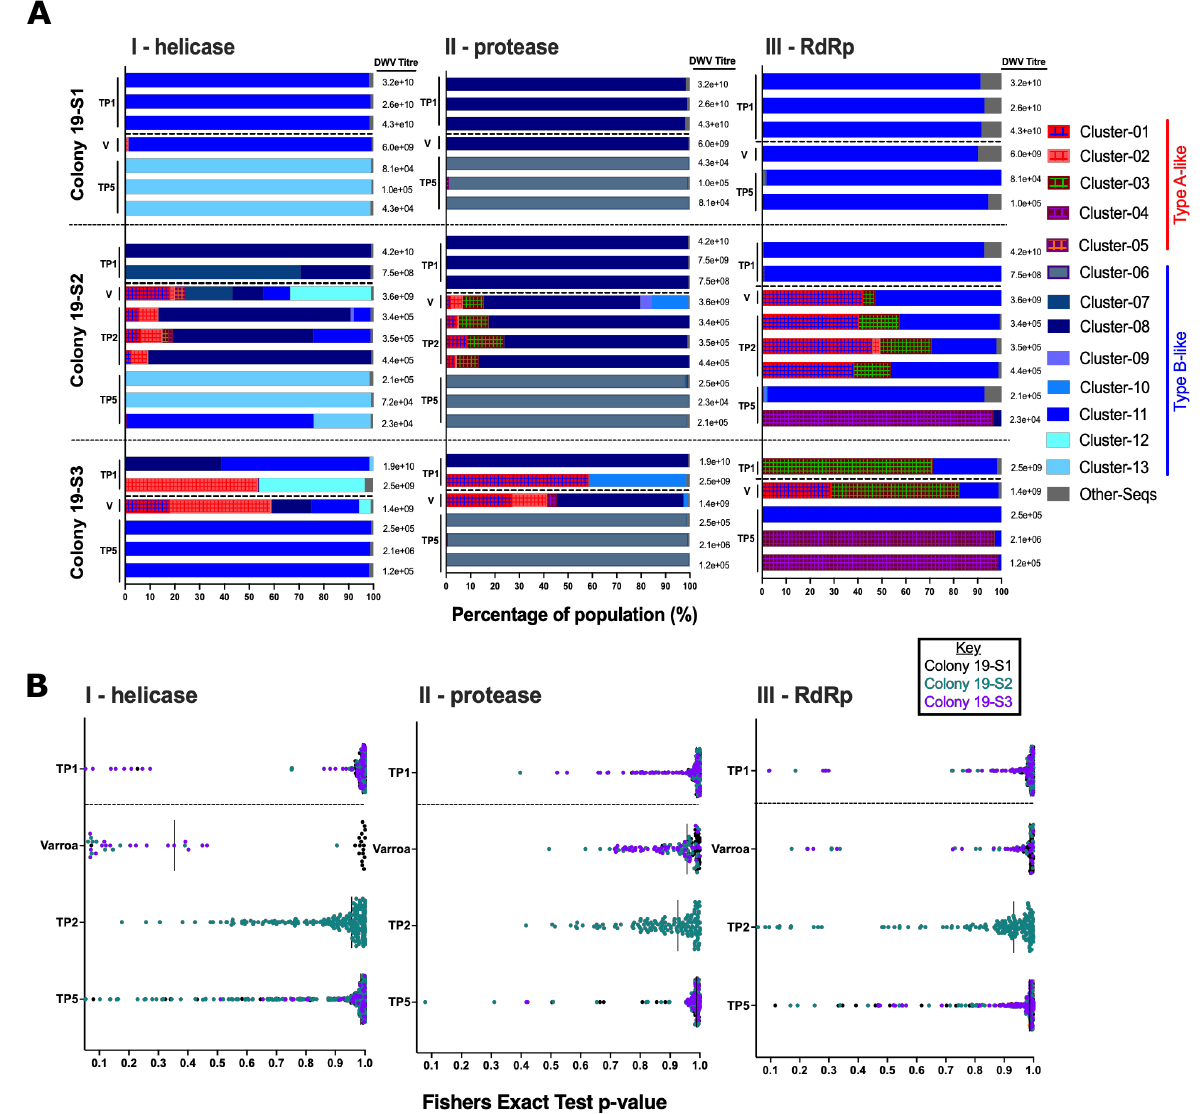
Figure 2. Analysis of DWV sequence diversity in shook swarm samples using ShoRAH compiled haplotypes and Single nucleotide variants (SNVs) analysis. Panel A - The different colours at each time point represent the Type A and B haplotypes from each colony, with red representing Type A variants and blue representing Type B. The Type A haplotype clusters are also cross-hatched to further distinguish them from one another. Varroa pools (V) are shown separately from the TP1 honey bee samples and were collected 24 hours after miticide application. Haplotypes were generated from next generation sequence data and assigned to phylogenetic clusters for the helicase (I), protease (II) and RdRp (III). The bars are coloured red if they best- matched Type A-like sequences and blue if they best-matched Type B-like sequences in Figure S2. The quantified viral load in each honey bee is shown beside each bar. The dashed line indicates when the shook swarm was carried out. Panel B - SNVs from ShoRAH analysis for all samples from the helicase (I), protease (II) and RdRp (III) were analysed if present in 3 iterations of the modelling. Samples are coloured by colony. SNV p-values close to 1.0 represent a nucleotide variant present in the majority of sequences in that dataset differing from the reference sequence. Samples with SNVs with lower p-value scores therefore have a greater amount of sequence variation within the sample. The vertical bar on each plot indicates the median p-value score for all samples. Anything with a p-value <0.05 was excluded based on the defined threshold for error.